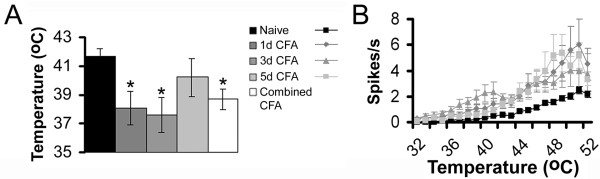
Inflammation-induced heat sensitization of TRPV1-negative CPM-fibers. A) Heat thresholds of CPM-fibers were significantly reduced 1 (dark grey bar) and 3 days (medium grey bar) after the injection of CFA and indistinguishable from those in naïve animals (black bar) at day 5 (light grey bar). The combined heat threshold of all time points after inflammation (white bar) was significantly lower than in naïve animals. B) The firing rates of CPM-fibers to noxious heat stimuli (grey symbols) were significantly higher at all time points after inflammation when compared to those from naïve mice (black squares).